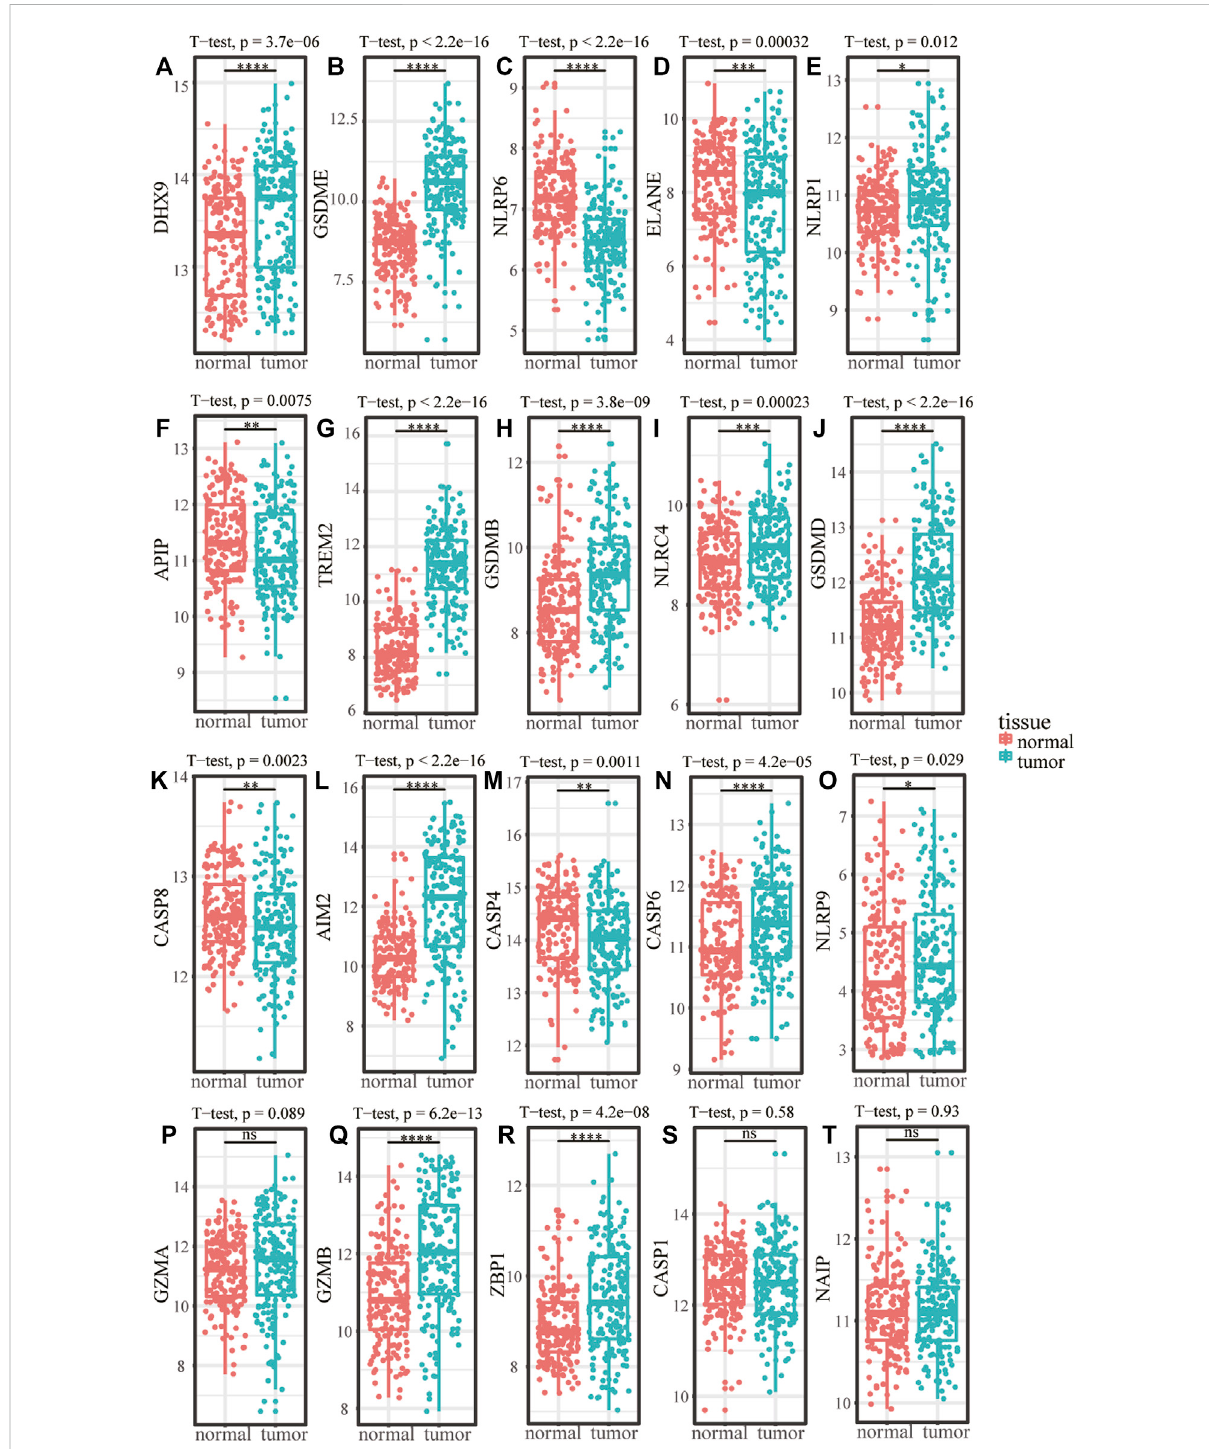
FIGURE 2 The expression difference of pyroptosis genes in ESCC. (A – T) Expression difference of pyroptosis genes between normal samples and tumor samples in GSE53625. * p < .05; ** p < .01; *** p < .001; **** p < .0001; ns, p >